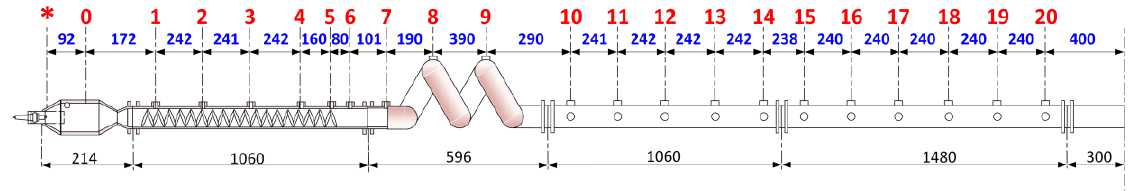
Figure 11. Schematic of the pulsed detonation tube used for systematic experimental studies of DDT in stoichiometric methane–air, propane–air, and ethylene–air mixtures diluted with hydrogen with the hydrogen dilution ratio changing from 0 to 1.